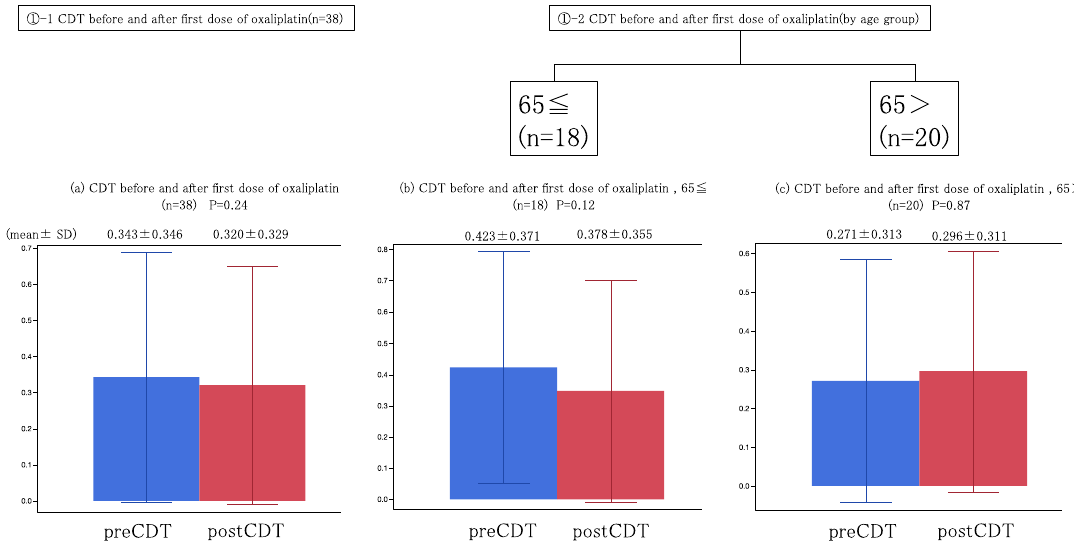
Figure 2 Comparison of the cold sensation detection threshold (CDT) before and after the first administration of oxaliplatin. The CDT was determined by applying menthol before and after the first oxaliplatin